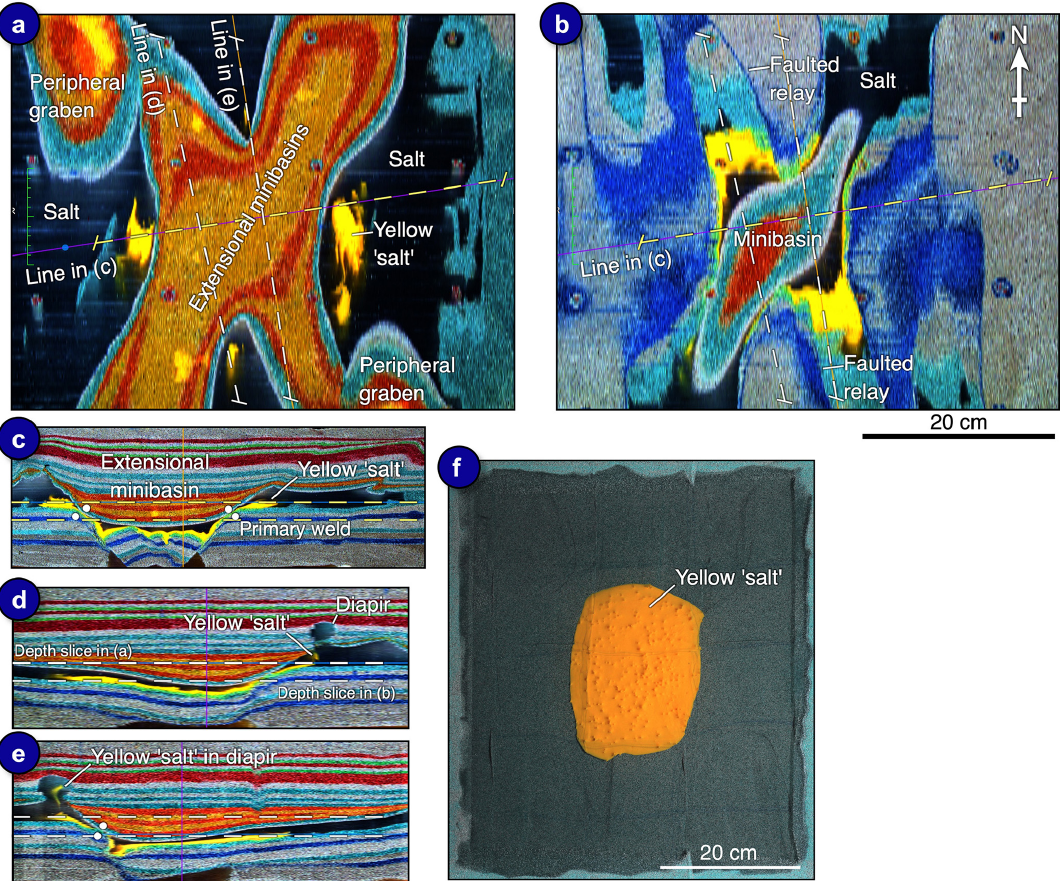
Figure 11. Details of Model 3. ( a and b ) Depth slices through Model 3. (c–e) Arbitrary lines through a portion of Model 3. (f) Original location of yellow marker “salt” in the central graben of Model 3. See text for further details.